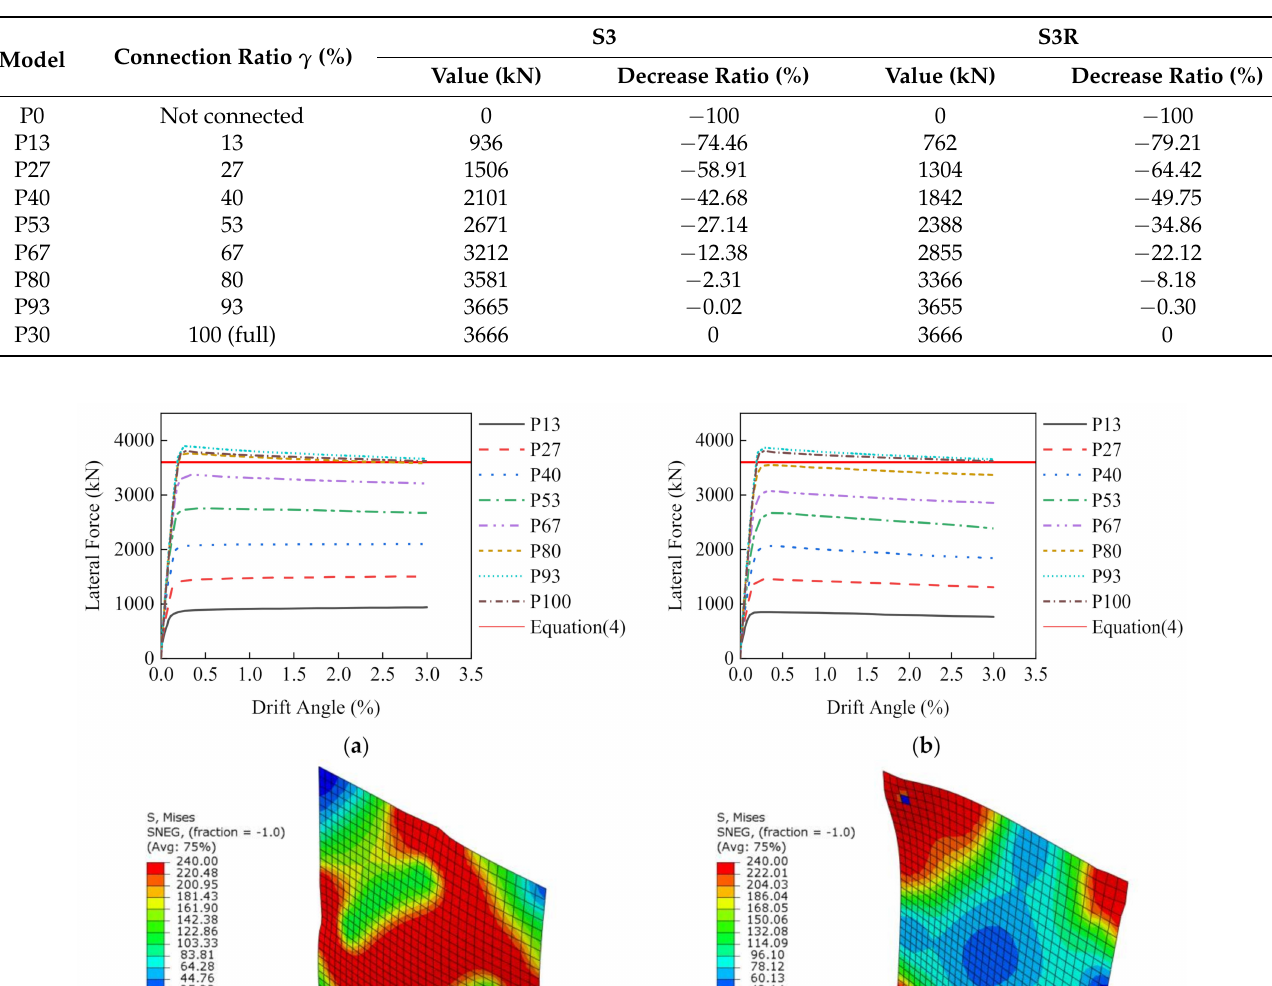
Table 5. Results of shear strength for S3 and S3R models.